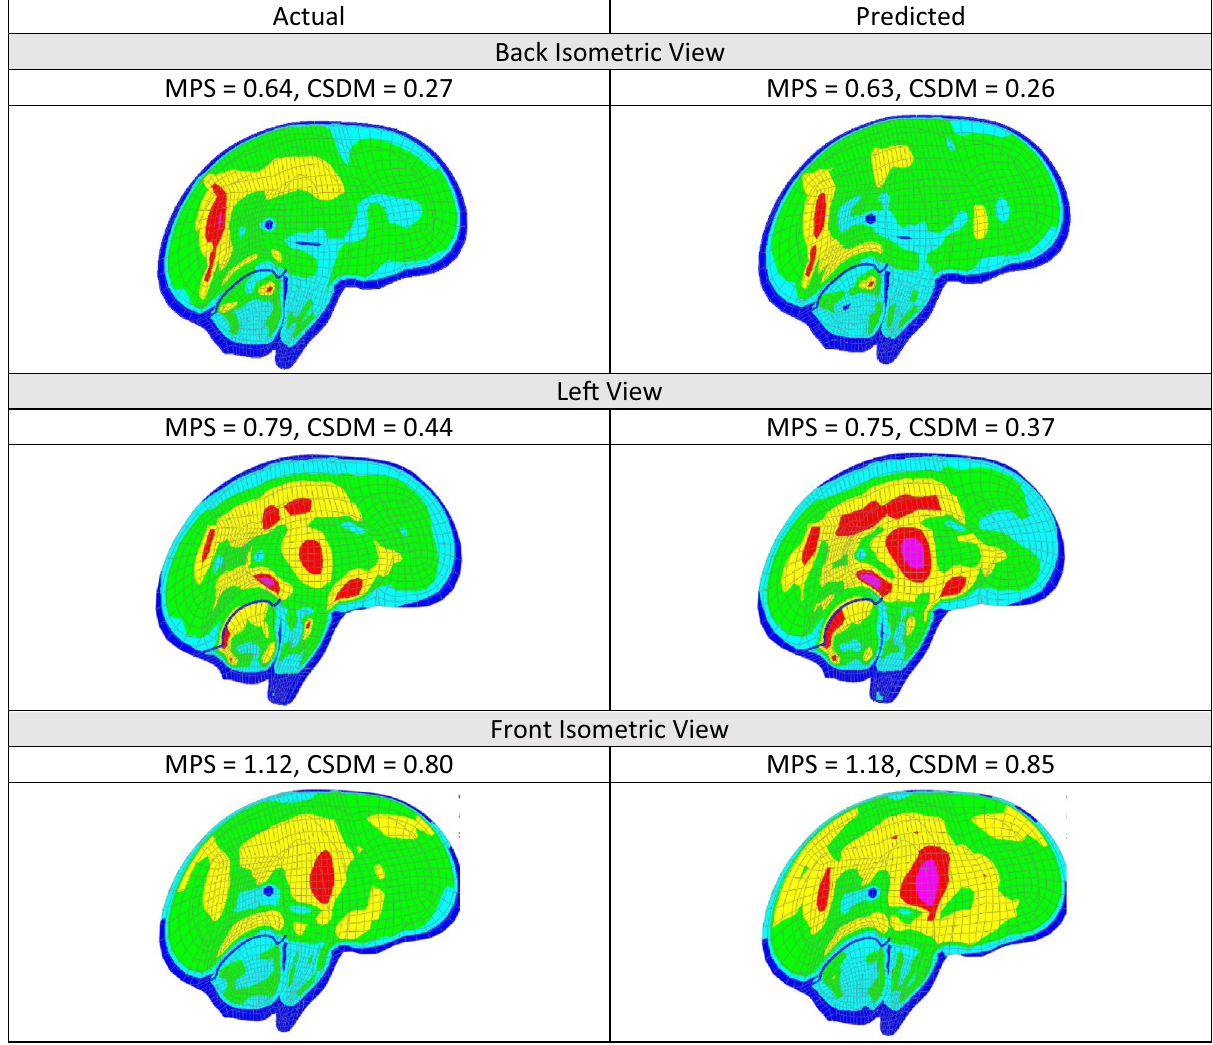
Figure 13. Brain strain